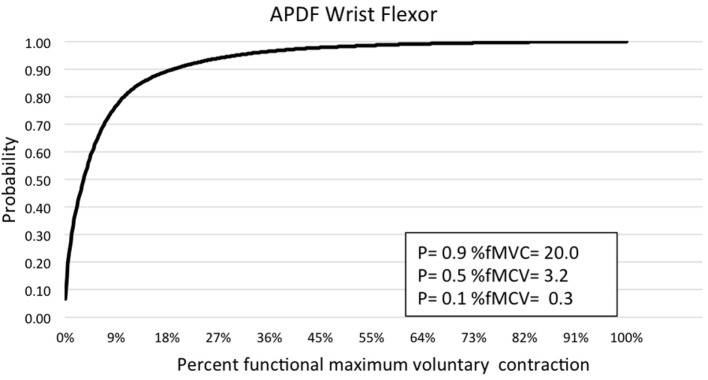
Graphic representation of typical APDF of the wrist flexors in the forearm.